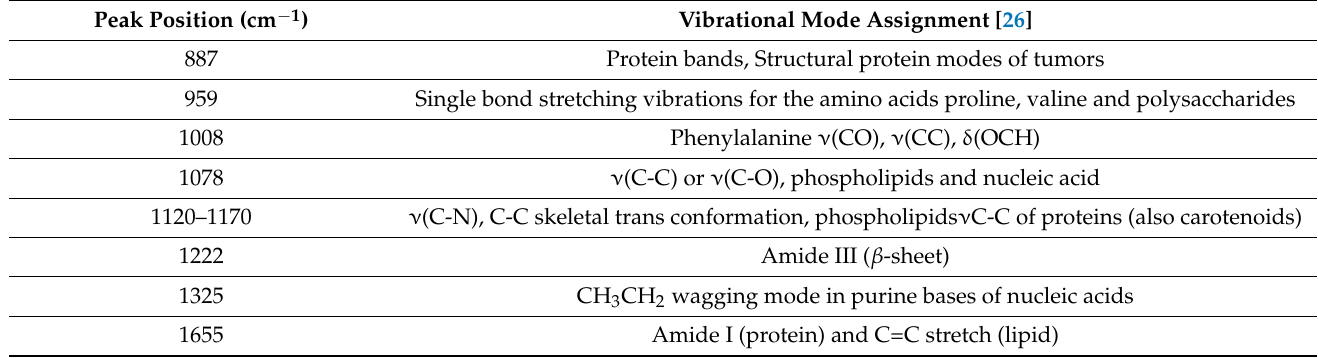
Figure 4. ( a ) Mean-centered, preprocessed mean Raman spectra and their differences for all cancer (n = 22) and control (n = 12) groups within a wavenumber range 735 – 1700 cm −1 . ( b ) Two-dimensional Scatterplot for first two latent LVSs from the PLS-DA classification model . ( c ) Receiver operating curve (ROC) demonstrating classification capability of PLS-DA classification model at different thresholds. ( d ) Variable importance in projection (VIP) score highlighting important discriminative wavenumber bands between lung cancer and control groups. Table 3. Assignment of Raman wavenumbers and bands evaluated using VIP score. ν = stretch, δ = deformation [28] .